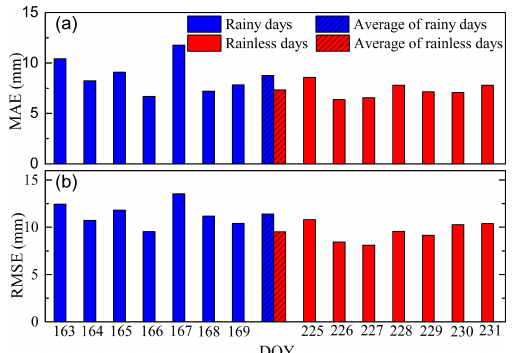
Figure 7. Comparison of SWV residuals (differences between the tomography-computed SWV and GAMIT-estimated SWV) for the KYC1 station in each elevation bin; (a,b) for RMSE / MAE; (c, d) for normalized RMSE /